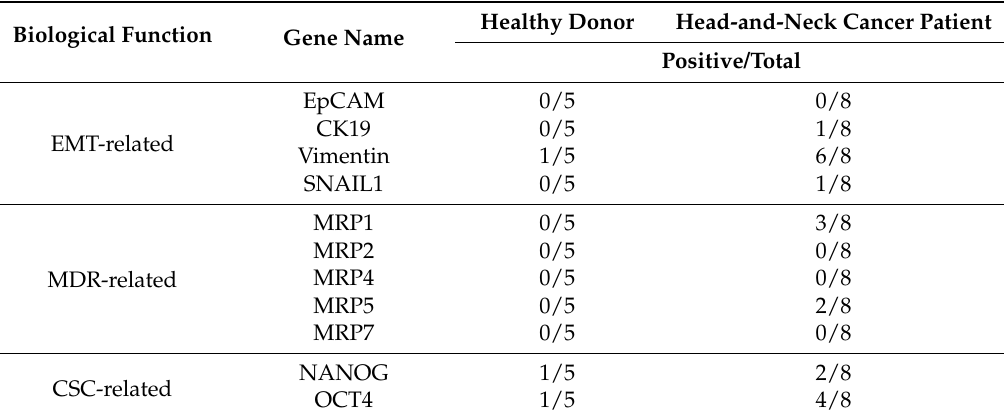
Table 1. Gene expression status of CD45 neg /EpCAM neg nucleated cells isolated from the blood samples of healthy donors and head-and-neck cancer patients. Biological